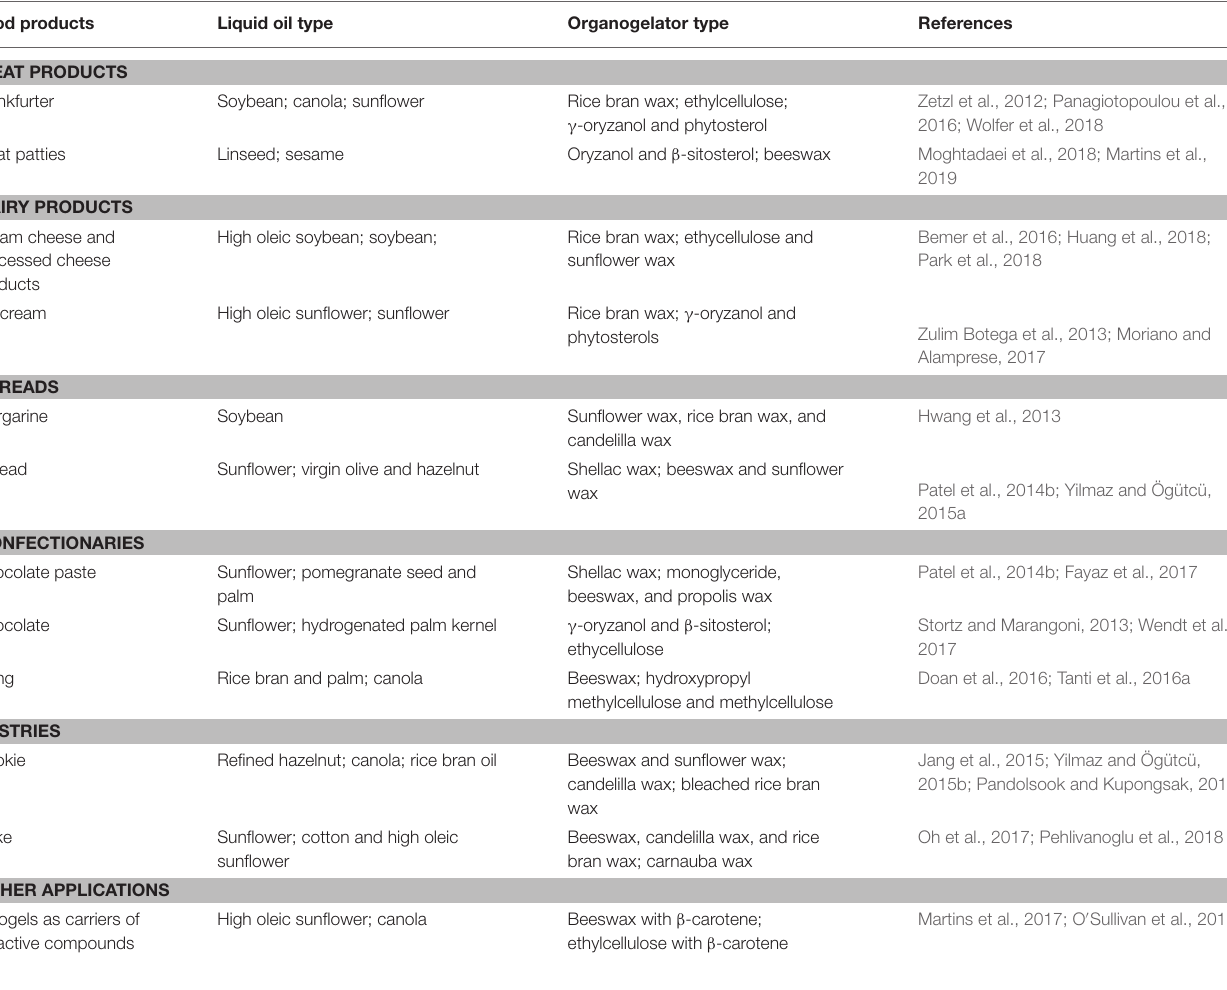
TABLE 1 | Examples of oleogel applications in food product